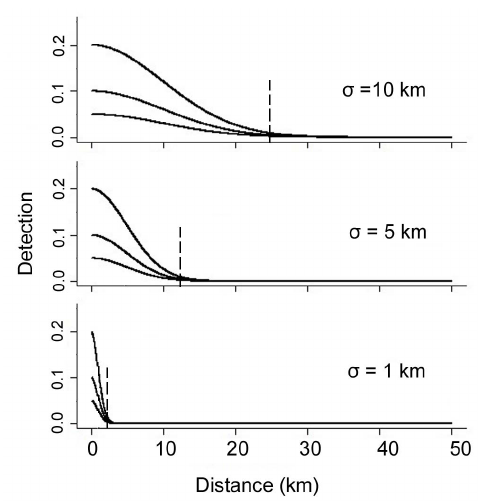
Figure 2. Nine detection scenarios by varying s and p 0 . Nine detection scenarios for N=500 were created by evaluating three values of the spatial scale parameter, ( s =10, 5, and 1 km), for each of three baseline detection rates, (p 0 =0.20, 0.10, 0.05). As distance from an individual’s activity center increases, detection decreases according to a half-normal function based on the two parameters. Dashed vertical p lines indicate 95% home range radii ( s * ffiffiffiffiffiffiffiffiffi 5 : 99 ).